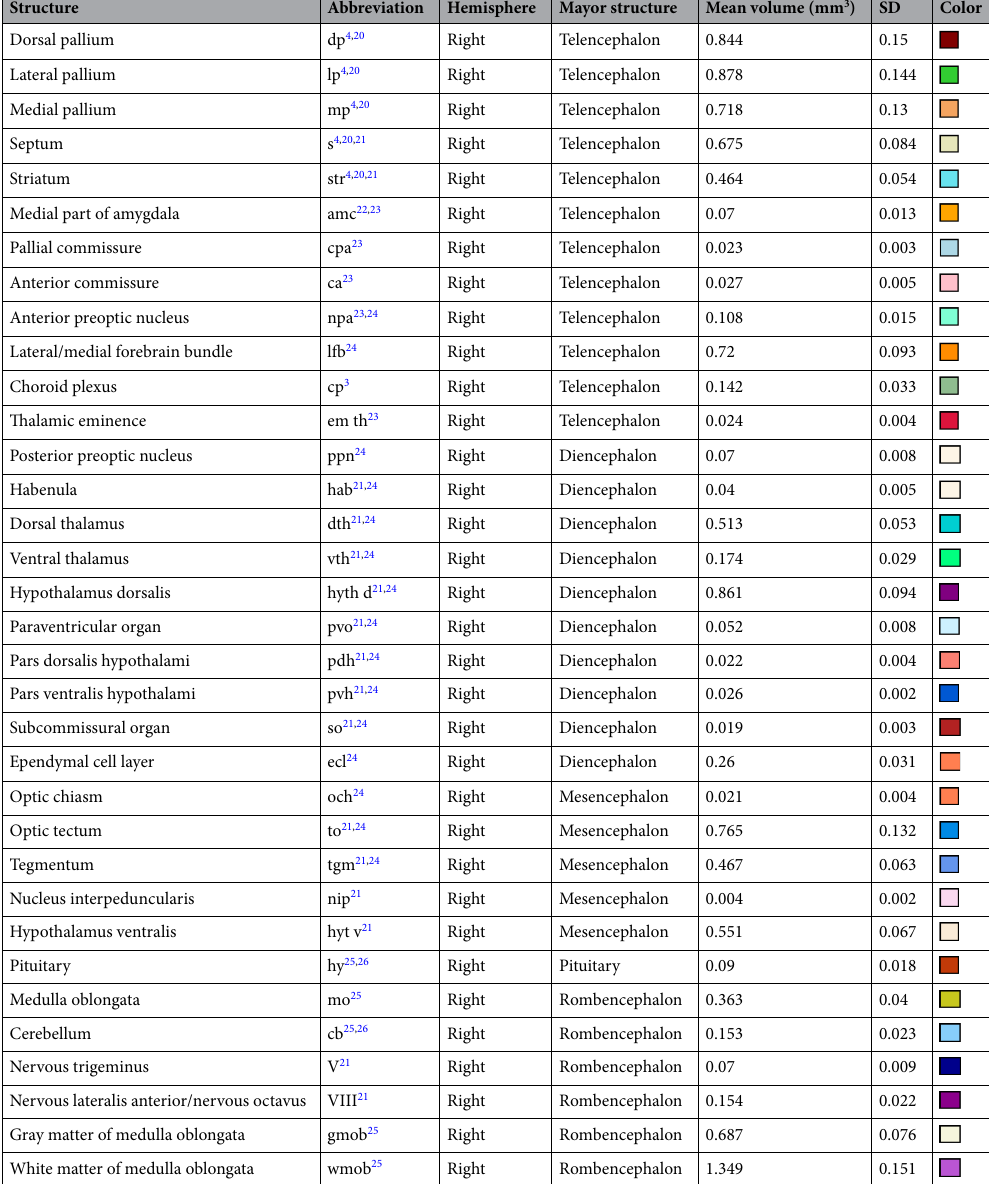
Table 1. List of ROIs, abbreviations, references, hemisphere, mayor structure, volume, standard deviation (SD) and